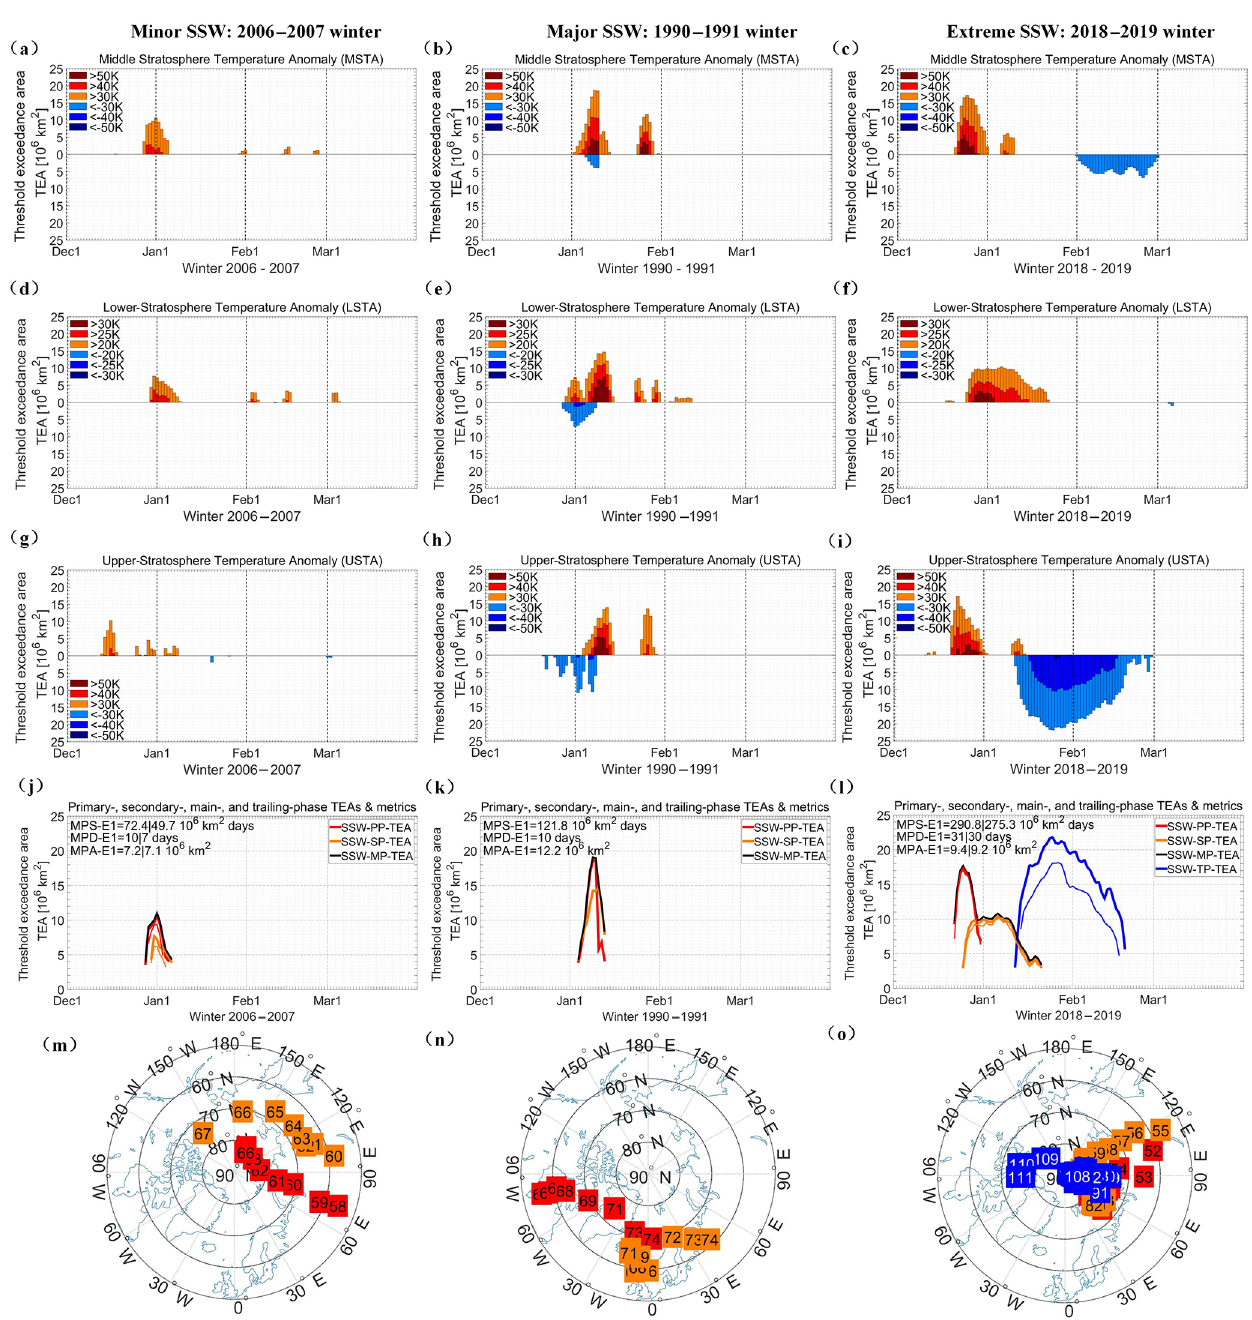
Figure 7. Time evolution of the daily ERA5 MSTA (a–c) , LSTA (d–f) , and USTA (g–i) threshold exceedance areas (TEAs) for the same minor (a, d, g, j, m) , major (b, e, h, k, n) , and extreme (c, f, i, l, o) SSW events, as illustrated in Fig. 6. Panels (j) – (l) depict the four derived SSW TEAs (SSW-PP-TEA, SSW-SP-TEA, SSW-MP-TEA, and SSW-TP-TEA in case it occurs) according to Table 1, lines (7)–(10); the SSW metrics MPS, MPD, and MPA (see Table 2) are also noted in each panel, and heavy and light lines denote ERA5 and RO results, respectively (difference especially visible for the extreme event). Panels (m) – (o) illustrate geographical tracks (numbered by day of winter as of 1 November) of maximum positive and negative anomaly values of SSW-PP-TEA (red), SSW-SP-TEA (orange), and SSW-TP-TEA